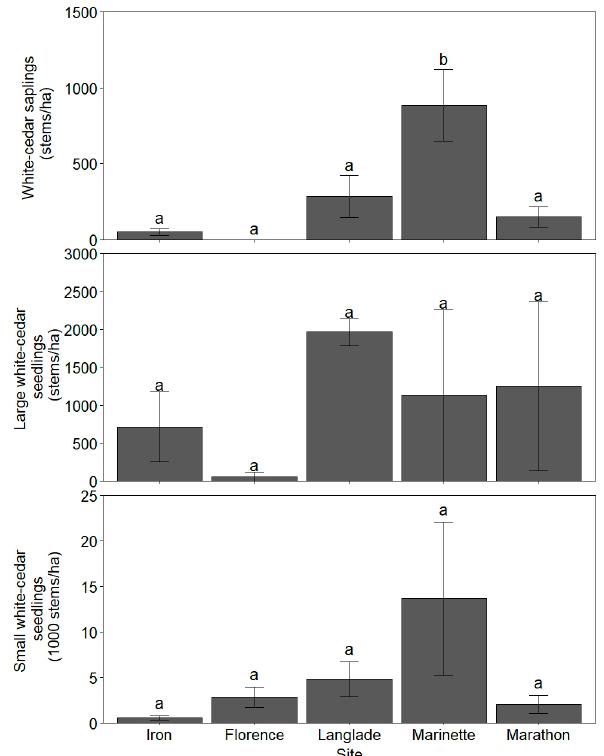
Figure 2. White-cedar regeneration by height class at each study site. Letters indicate significant di ff erences ( p < 0.05) in stem densities among study sites using Tukey’s HSD. Error bars indicate one standard deviation. Saplings were 1.83 m tall to less than 10 cm dbh, large seedlings were 20 cm to < 1.83 m tall, and small seedlings were less than 20 cm tall. Note that y-axes di ff er in each